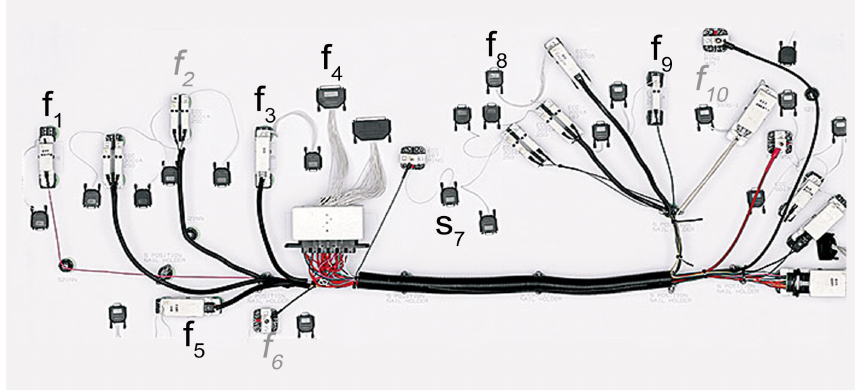
Figure 3. Illustration of the distribution of the fixtures on an assembly table. As the fixtures move according to the tables of the conveyor system, the fixtures are identically placed at every workstation. The fixtures labeled with gray text are inactive as there are no related activities at the depicted workstation.